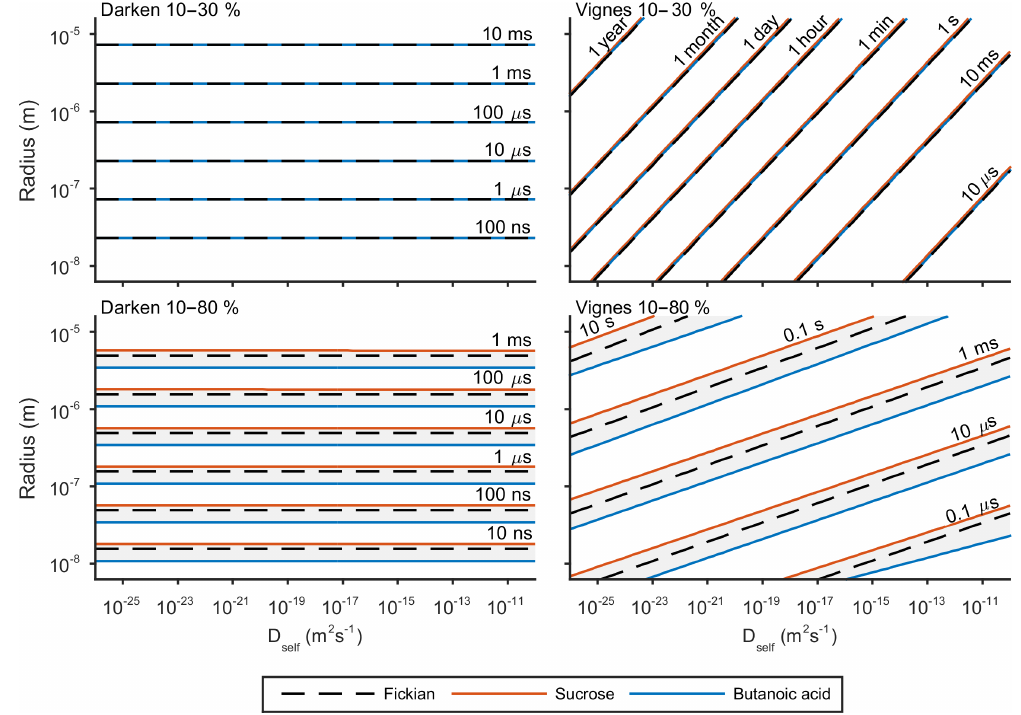
Figure 5. The e -fold time contours for both the Darken and Vignes mixing rules and how they depend on initial particle radius and self- diffusion coefficient of the non-volatile organic compound. In both cases e -folding times have been found for increases in relative humidity from 10 to 30 and 80%. The black dashed line represents the e -fold contour found using the Fickian framework. The grey shaded area represents the sensitivity in the model due to the range in solubility between sucrose and butanoic acid given by the red and blue lines respectively. The simulations were run at a temperature of 293 . 15K with initially 30 shells equally distributed across the radius of the